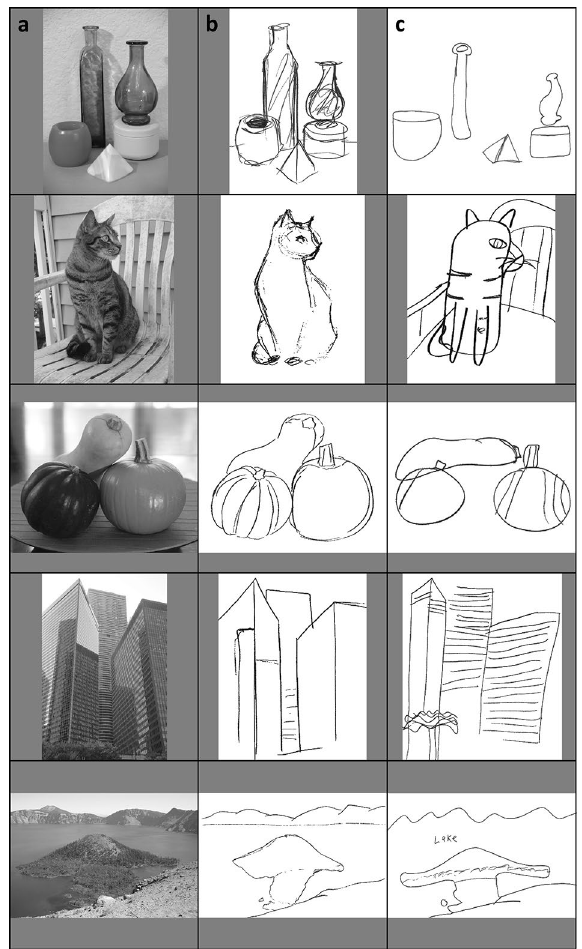
Figure 4. Examples of stimuli and drawings from the 5 image categories (still-life, animal, plant, buildings, and landscape). Participant renditions were rated for accuracy on a scale from 1 to 5. The images in column ( a ) show one example photo from each category. High-rated drawings (rated above the mean) for each example photo are shown in column ( b ) and low-rated drawings (rated below the mean) for each example photo are shown in column ( c